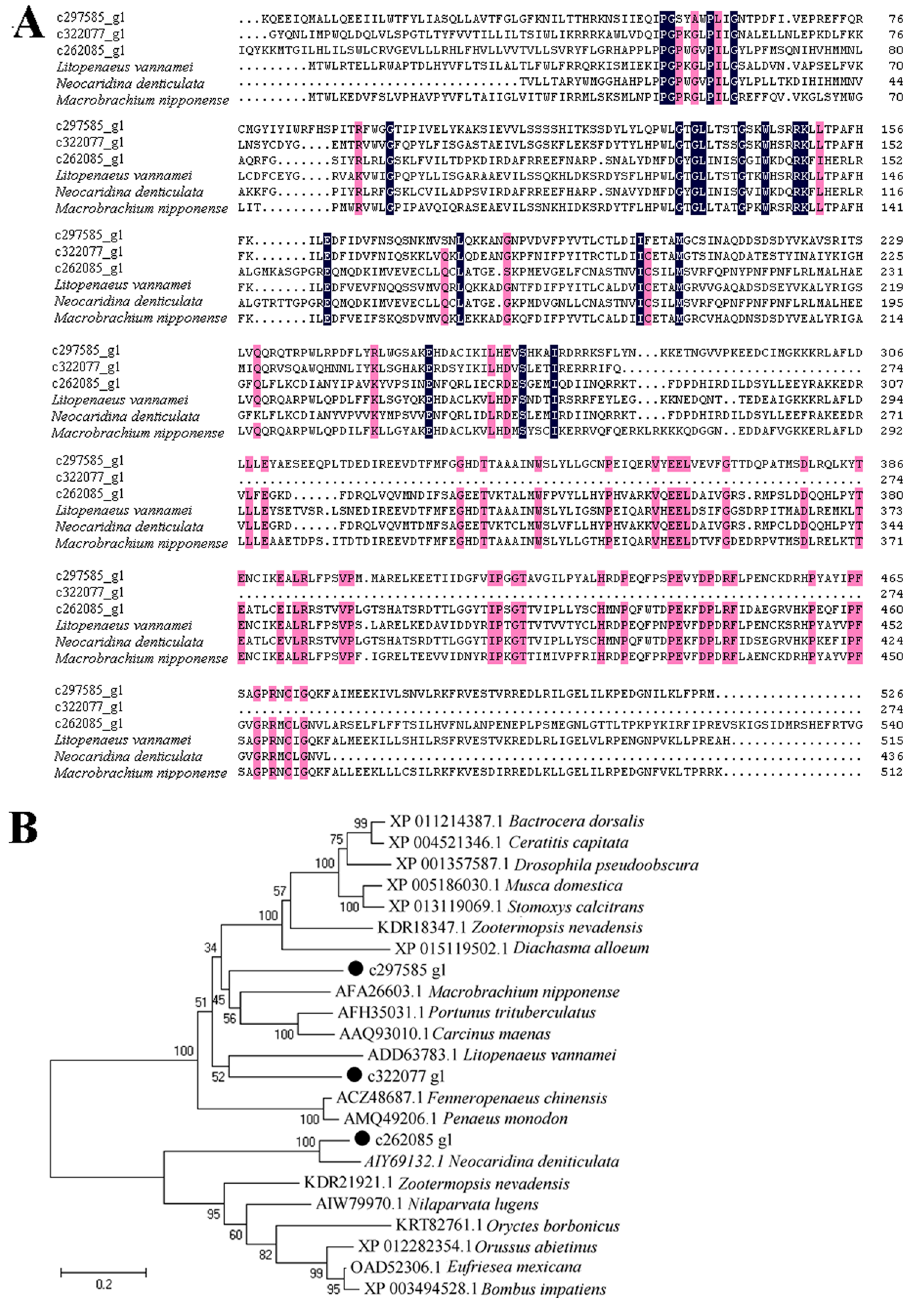
Figure 6. Sequence analysis of cytochrome P450 (CYP450) that was upregulated in Rimicaris sp. ( A ) Sequence alignment of CYP450 from Rimicaris sp., Litopenaeus vannamei Neocaridina denticulate , and Macrobrachium nipponense . The consensus residues are in black; the residues that are ≥ 75% identical among the aligned sequences are in pink. ( B ) Phylogenetic analysis of CYP450 by distance-based neighbor-joining method with 1,000 bootstrap replicates. The sequences marked with “ ● ” are from this study. The GenBank Accession numbers of the aligned sequences are as follows: Litopenaeus vannamei , ADD63783.1; Neocaridina denticulate , AIY69132.1; and Macrobrachium nipponense ,